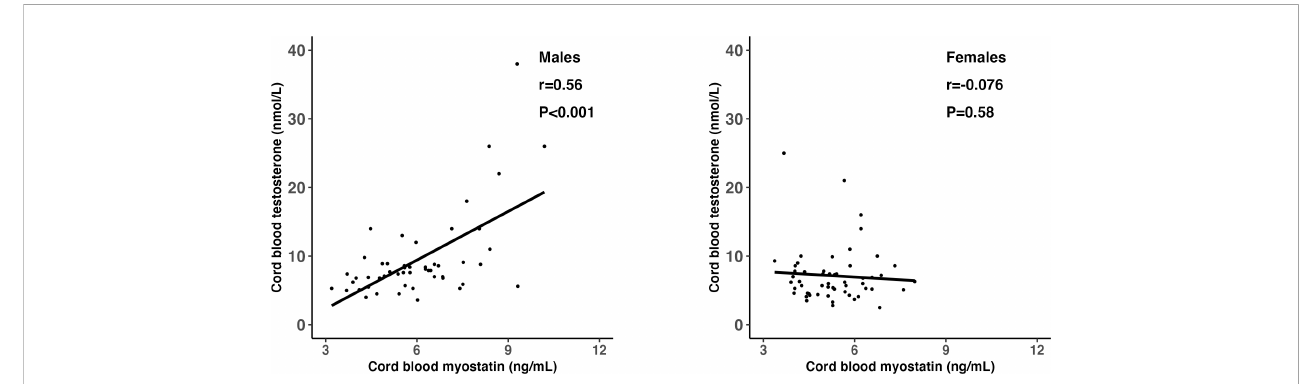
FIGURE 2 Scatter plots illustrating the differential correlations (r) between cord blood myostatin and testosterone in males and females; Fisher ’ s Z test for difference in r (correlation coef fi cient):